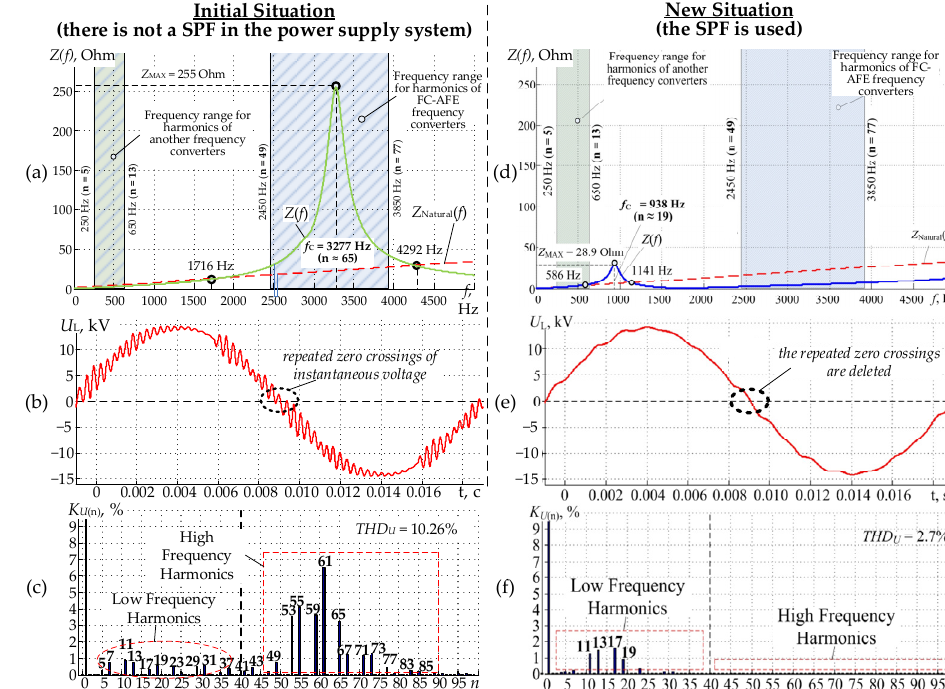
Figure 22. The comparison of frequency characteristics and voltage quality on the 10 kV bus bar at the long product mill’s switching substation: ( a ) the frequency response of the 10 kV grid without SPF; ( b ) the instant line voltage values without SPF; ( c ) the harmonic spectrum of line voltage without SPF; ( d ) the frequency response of the 10 kV grid with SPF; ( e ) the instant line voltage values with SPF; ( f ) the harmonic spectrum of line voltage with SPF.